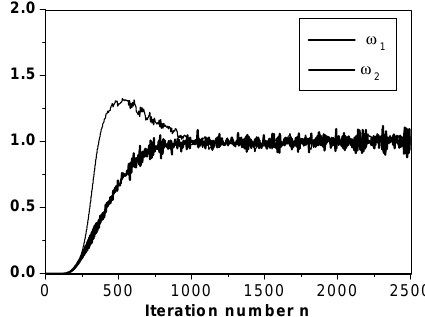
Fig. 19. Evolution of the normalized filter coefficients (transform-domain LMS ), case ( C 4